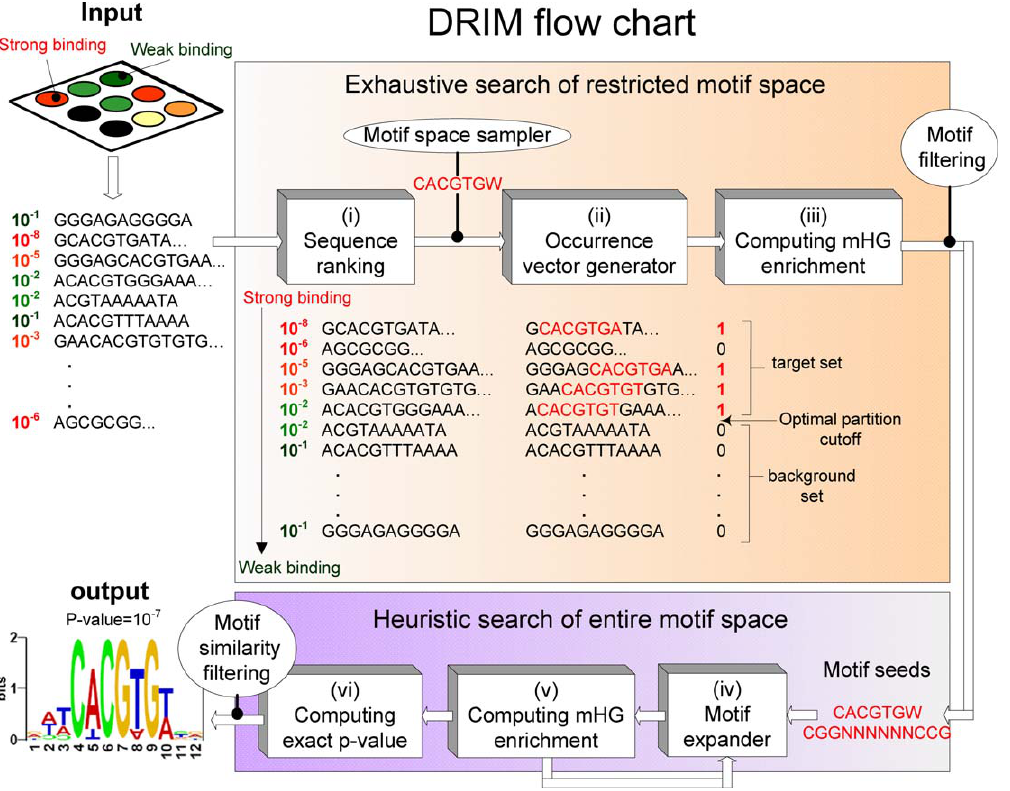
Figure 1. DRIM Flow Chart DRIM receives a list of DNA sequences as input and a criterion by which the sequences should be ranked, for example, TF binding signals as measured by ChIP ChIP–chip: (i) The sequences are ranked according to the criterion. (ii) A ‘‘ blind search ’’ is performed over all the motifs that reside in the restricted motif space (in this study the restricted motif space contains ; 100,000 motifs, see Methods, The DRIM software). For each motif an occurrence vector is generated. Each position in the vector is the number of motif occurrences in the corresponding sequence, (the figure shows the vector for the motif CACGTGW). (iii) The motif significance is computed using the mHG scheme, and the optimal partition into target and background sets in terms of motif enrichment is identified. The promising motif seeds are passed as input to the heuristic motif search model and the rest are filtered out. (iv,v) The motif seeds are expanded in an iterative manner (the mHG is computed in each lap), until a local optimum motif is found. (vi) The exact mHG p -value of the motif is computed. If it has a p -value , 10 (cid:2) 3 , then it is predicted as a true motif (the choice of this threshold is explained in Results, Proof of principle). The output of the system is the motif representation above IUPAC, its PSSM, mHG p -value, and optimal set partition